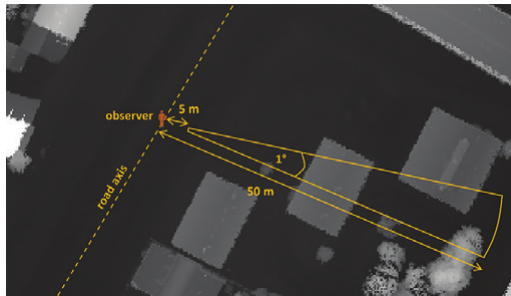
Fig. 9. Computing elevation for a given 1° azimuth using a Digital Surface Model